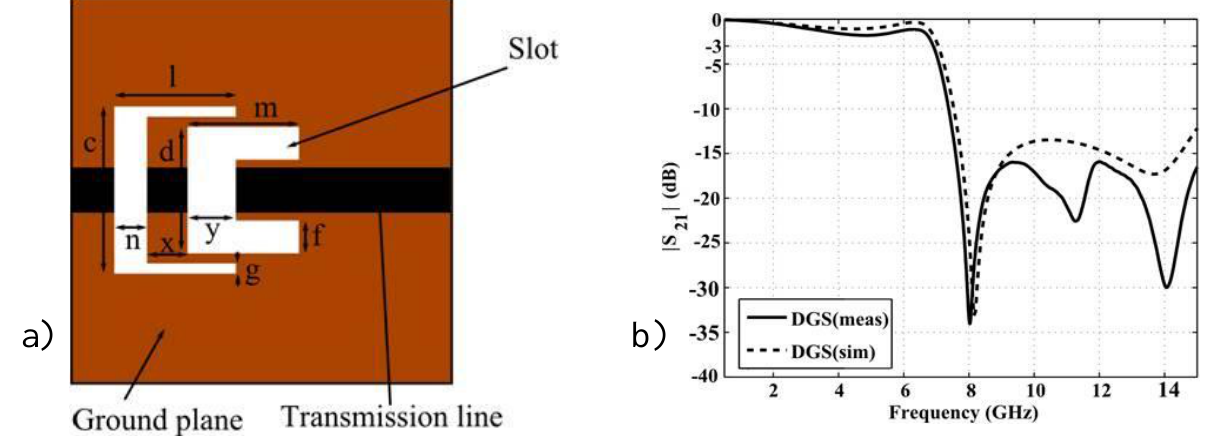
Figure 5. ( a ) Topology of defected ground structures (DGS) section (bottom view); and ( b ) transmission coefficient of DGS